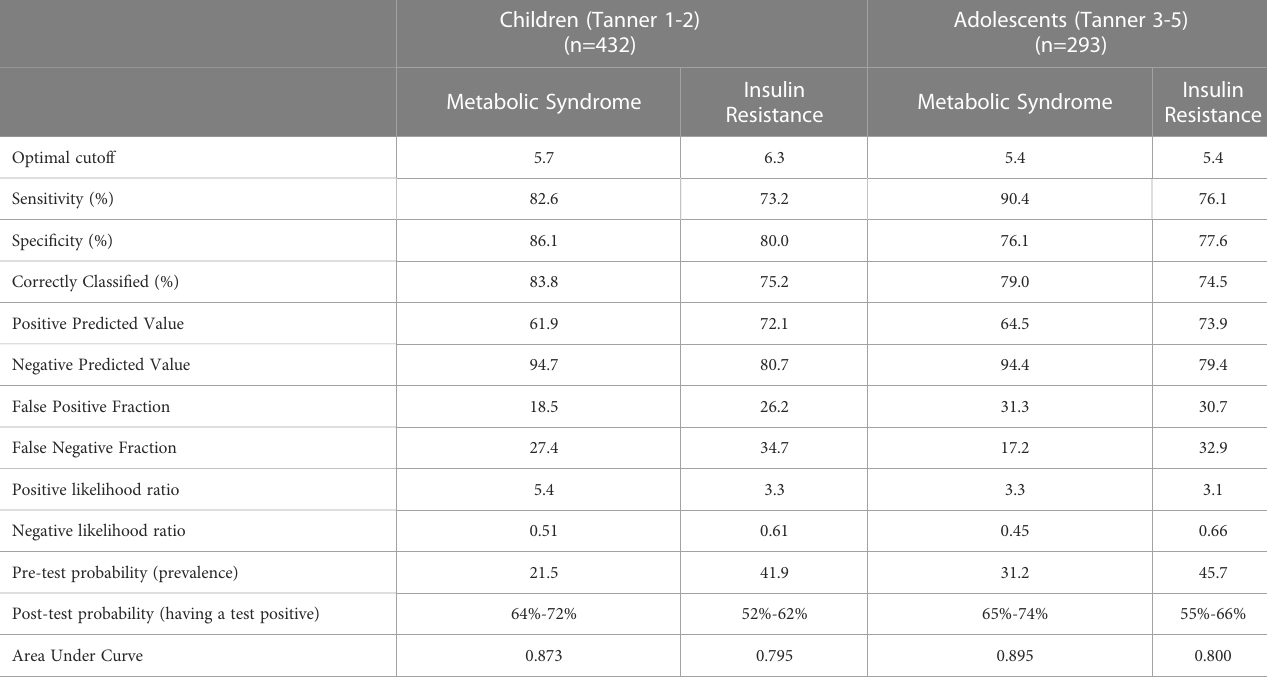
TABLE 2 Optimal cutoff values and summary indices of SPISE performance to predict Insulin Resistance and Metabolic Syndrome in children and adolescents with obesity